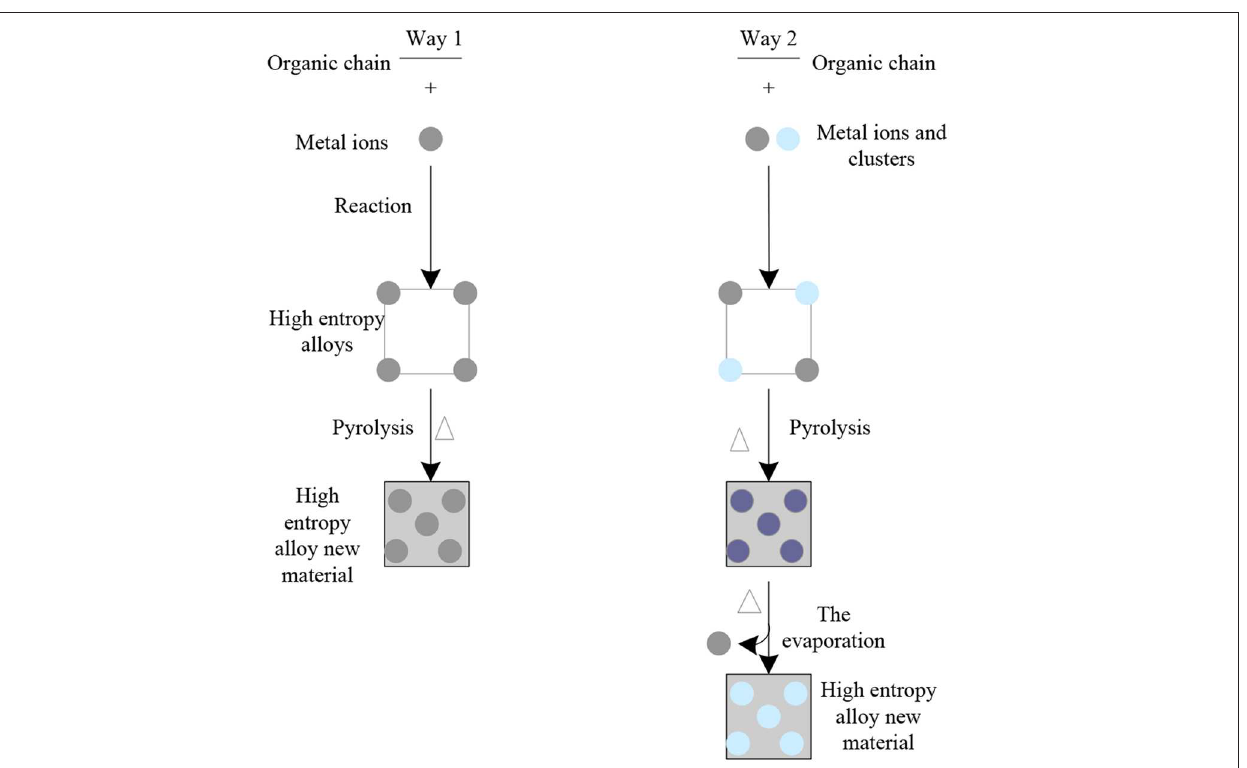
FIGURE 8 | Crystalline structure of NiCo high entropy alloy frame. Note: dark gray, C; Light gray, H; Red, O; Purple, Co; Green, Ni.